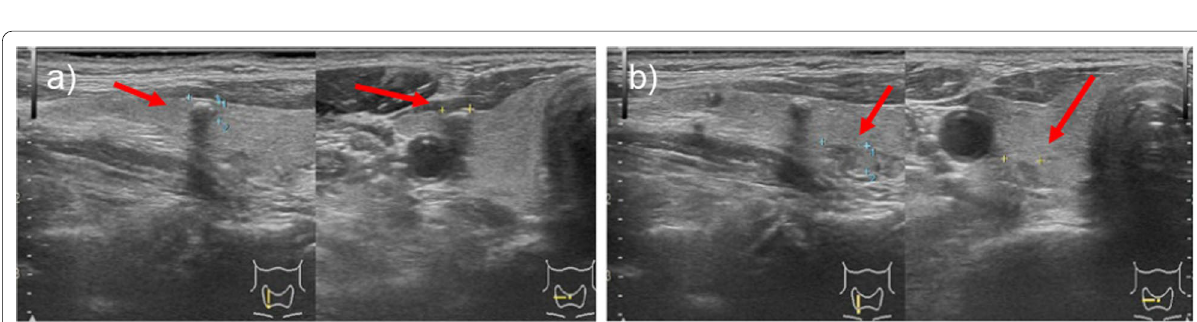
Fig. 3 Ultrasonographic findings of the thyroid tumors. a A hypoechoic mass with rim calcification, 4 mm in size, is found in the middle of the right lobe of the thyroid gland. b An irregular hypoechoic mass, 6 mm in size, is found in the middle of the right lobe of the thyroid